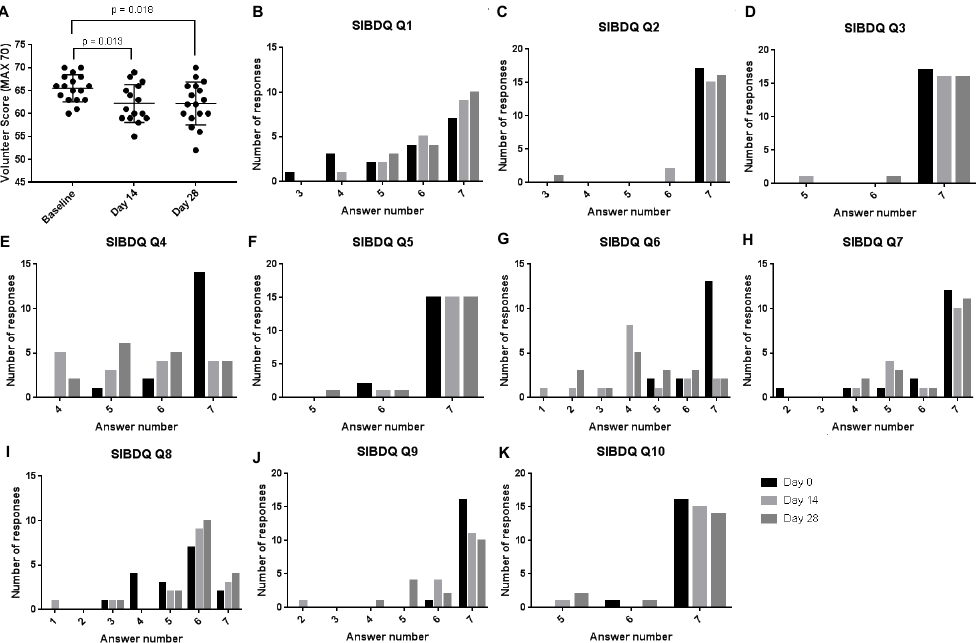
Figure 1. ( A ) S-IBDQ-score obtained from volunteer questions at baseline, day 14 and day 28. Each point represents a volunteer score with the midline and standard deviations plotted. Absolute histograms ( B – K ) of individual patient responses for each of the S-IBDQ questions (1–10 respective) at day 0, 14 and 28. Given p values represent statistical significance using an un-paired t -test with p < 0.05 denoting statistical significance.